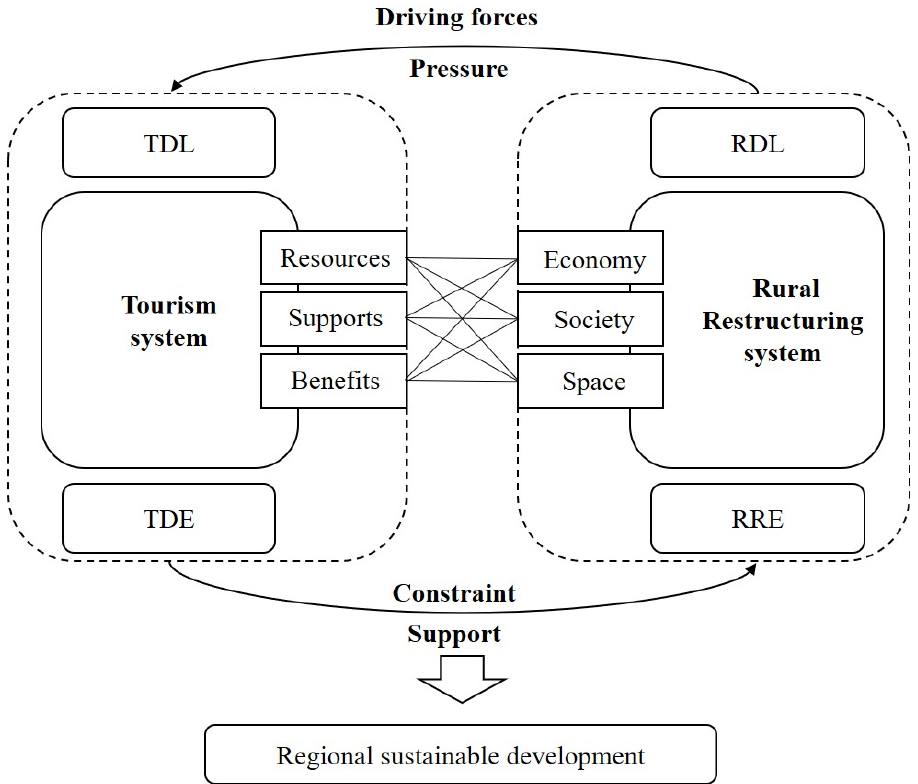
Figure 3. The TRR system. TDL is tourism development level, TDE is tourism development efficiency, RDL is rural development level, RRE is rural restructuring efficiency.